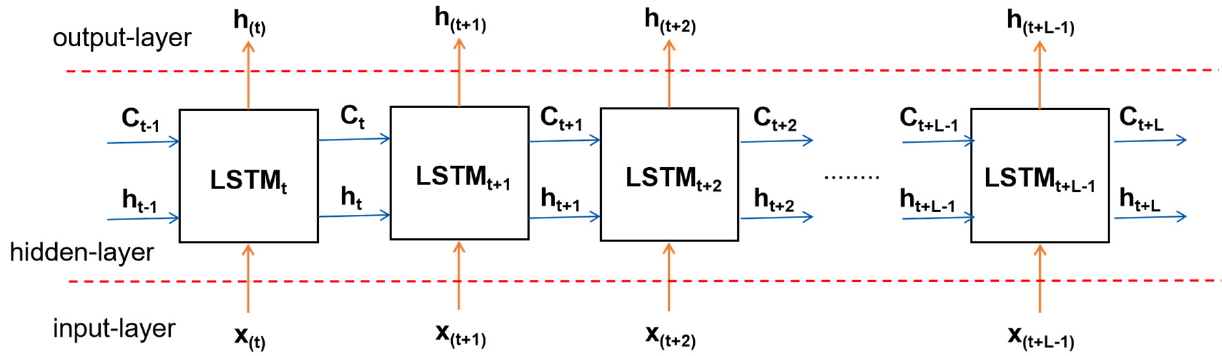
Figure 7. LSTM neural network topology.